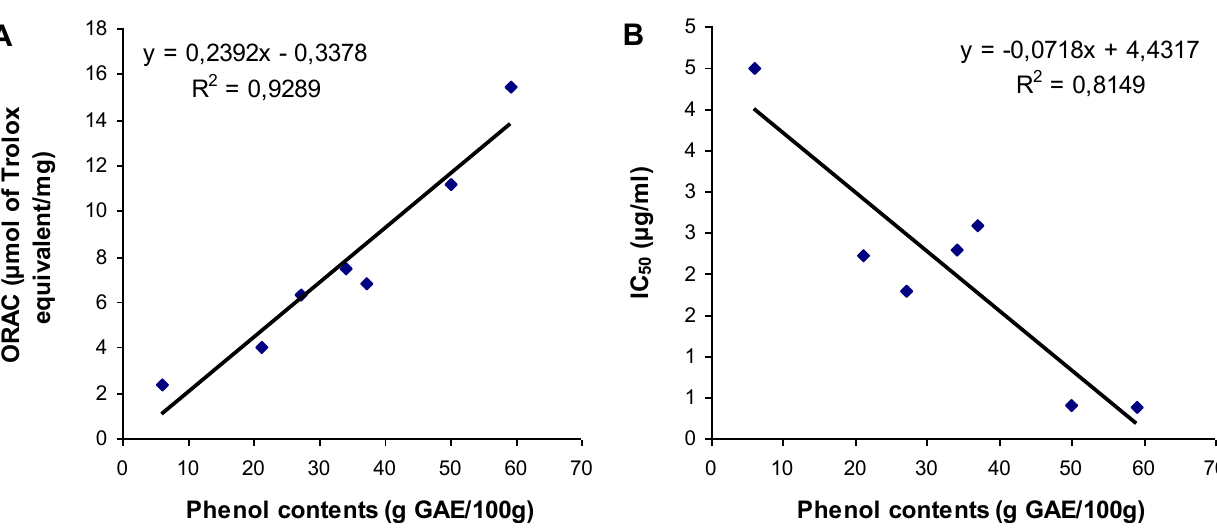
values of all water extracts 50